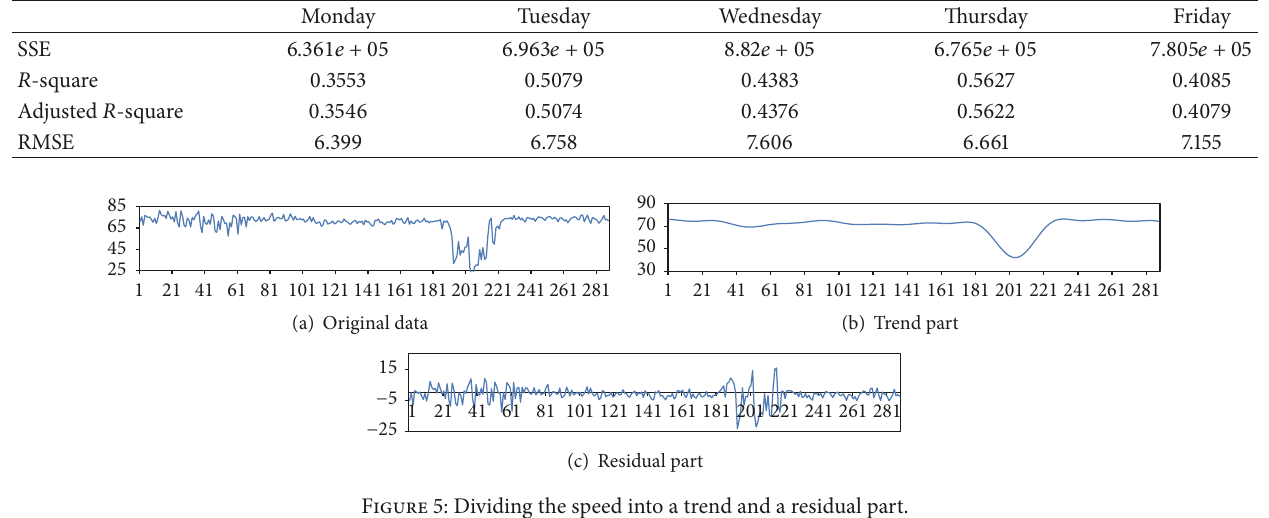
Figure 5: Dividing the speed into a trend and a residual part.